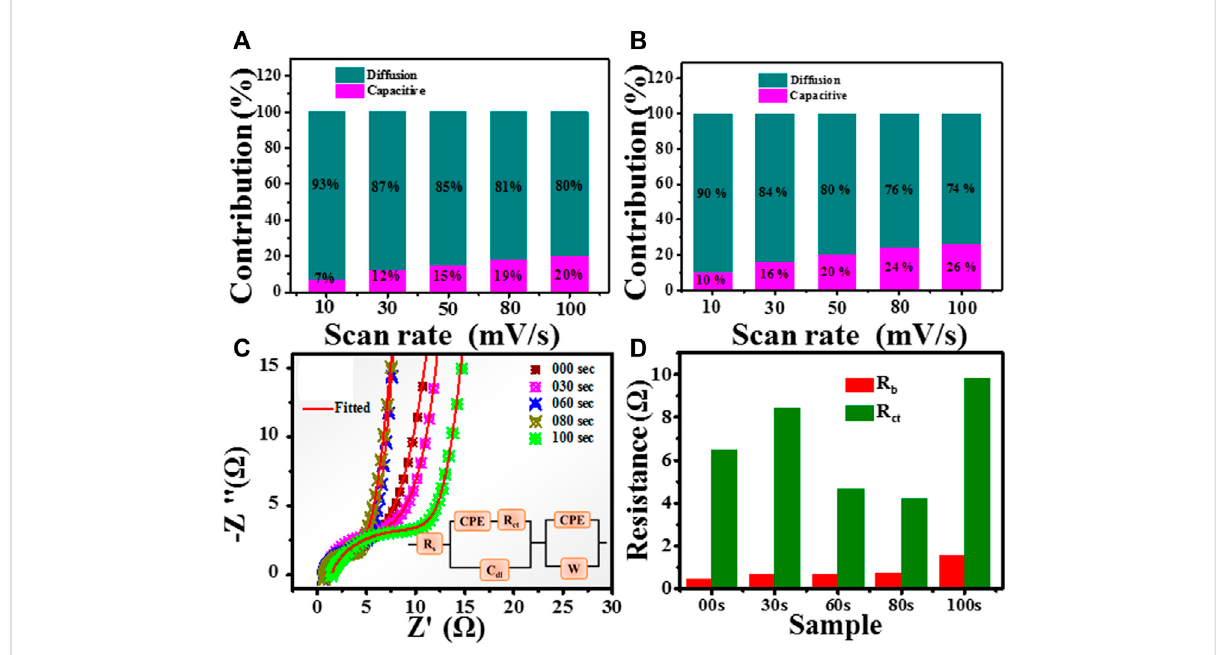
FIGURE 11 Comparison of capacitive contribution and diffusion-controlled contribution in (A) untreated (B) 80-s plasma treatment sample at different scan rates. (C) : Nyquistplot for untreated and treated samples. (D) : determined bulk and charge transferresistance for untreated and plasma treated